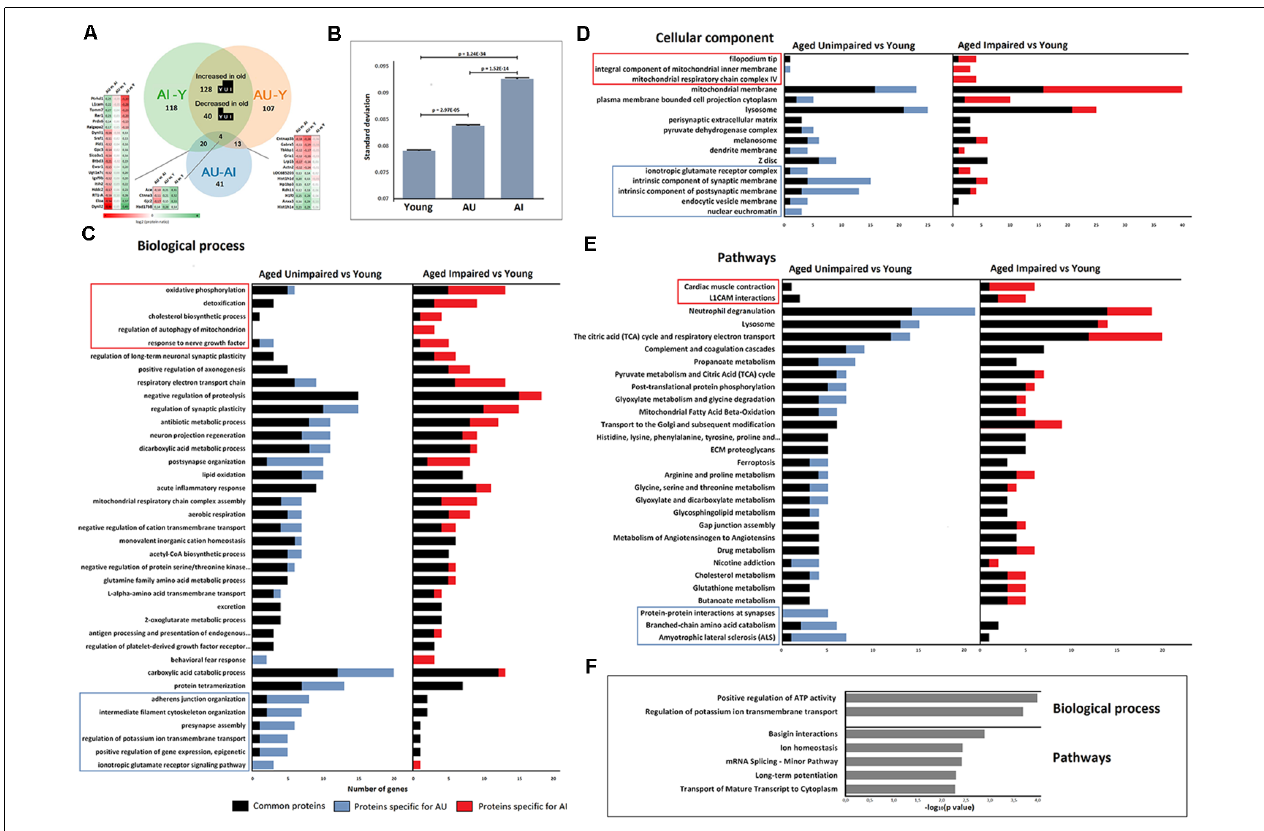
FIGURE 2 | (A) Venn diagram showing the relationship between AI vs. young, AU vs. young, and AU vs. AI significant proteins. (B) Analysis of variance (ANOVA) of protein levels revealed a significant increase in SD with age and with cognitive impairment (one-way ANOVA, t -test post hoc test). (C–E) Functional enrichment analysis was performed on the list of significantly changed proteins between young and two aging groups using ClueGO-Cytoscape platform (Benjamini–Hochberg P -values < 0.05). Displayed gene ontology (GO) terms are the most significant cases from significantly enriched clusters. GO terms in the frames were significantly enriched only in one group AU vs. young or AI vs. young. (F) Significantly enriched GO terms in the set of 77 proteins with different protein levels between AU and